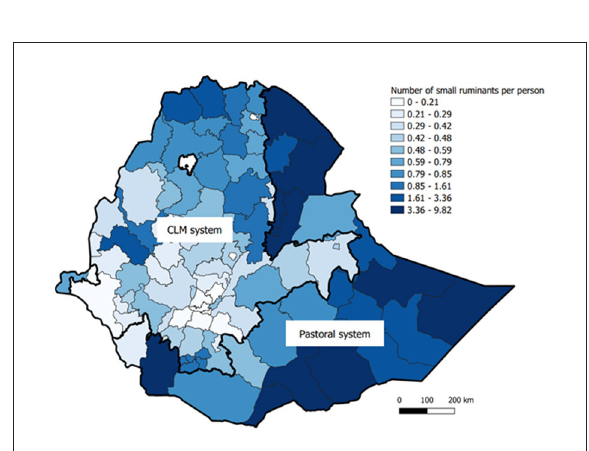
FIGURE3 Per capita distribution of small